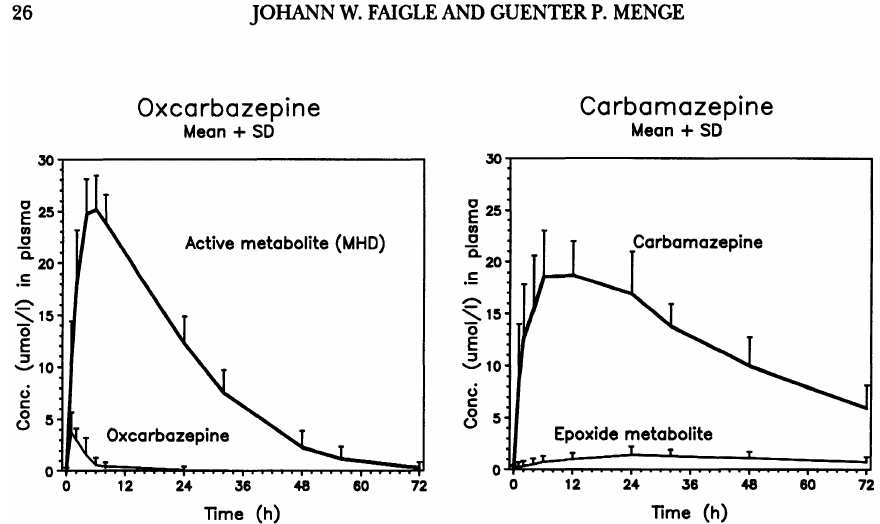
FIG. 3. Single-dose plasma concentrations in healthy subjects. (n= 6; 600 mg oxcarbazepine; 400 mg carbamazepine;